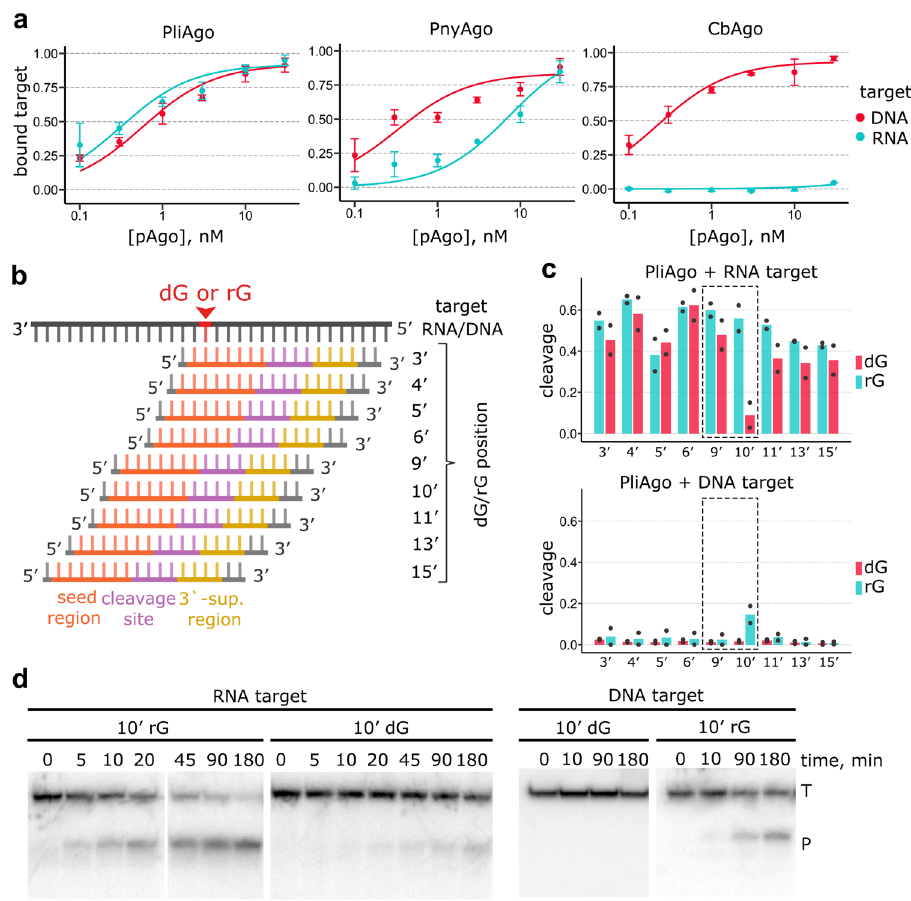
Fig. 4 | Speci fi city of target recognition by D-R pAgos. a Binding of target RNA and ssDNA of the same sequence by PliAgo, PnyAgo and CbAgo loaded with cog- nate guide DNA. Means and standard deviations from 3 independent experiments are shown. b Scheme of RNA/DNA targets containing a single dG/rG residue with differently positioned DNA guides (see Supplementary Table 1 for oligonucleotide sequences). Positions of the functional regions in guide DNA are indicated (seed, orange; central, magenta; 3 ’ -supplementary region, ochre). c Effects of a single deoxyribonucleotide (dG) in the RNA target (top) and a single ribonucleotide (rG)